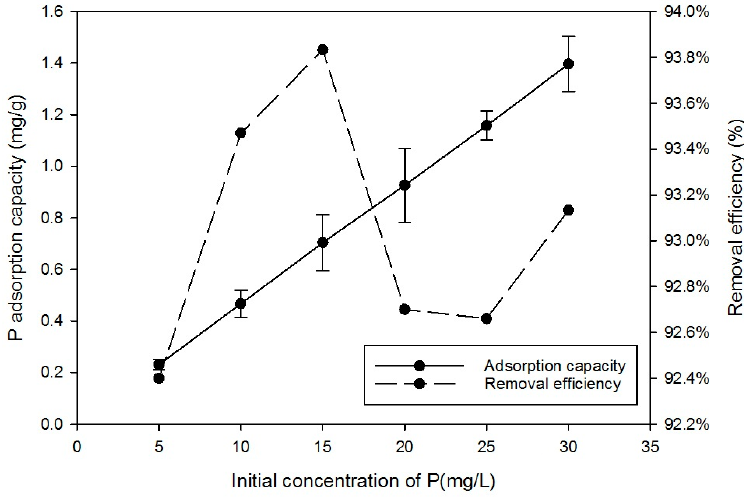
Figure 4. Effect of initial concentration of media on removal of P. Dose of media 2 g contact time 24 h; agitator 180-rpm; pH-5.